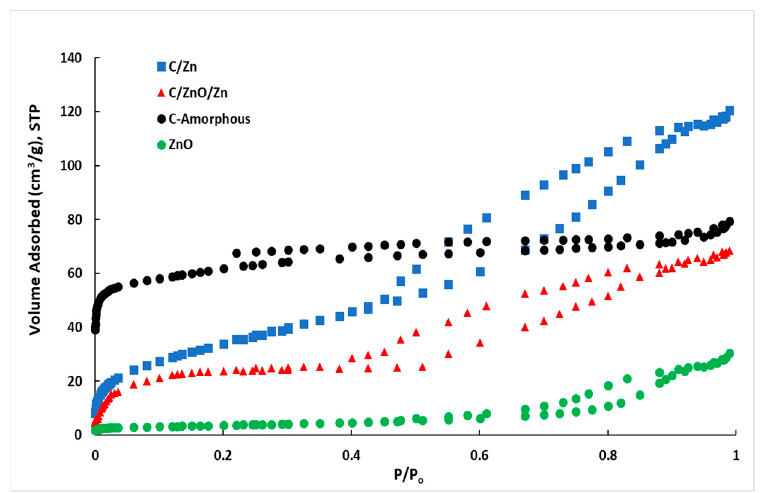
Figure 4. Adsorption–desorption isotherms of N 2 at − 196 °C for the different samples.